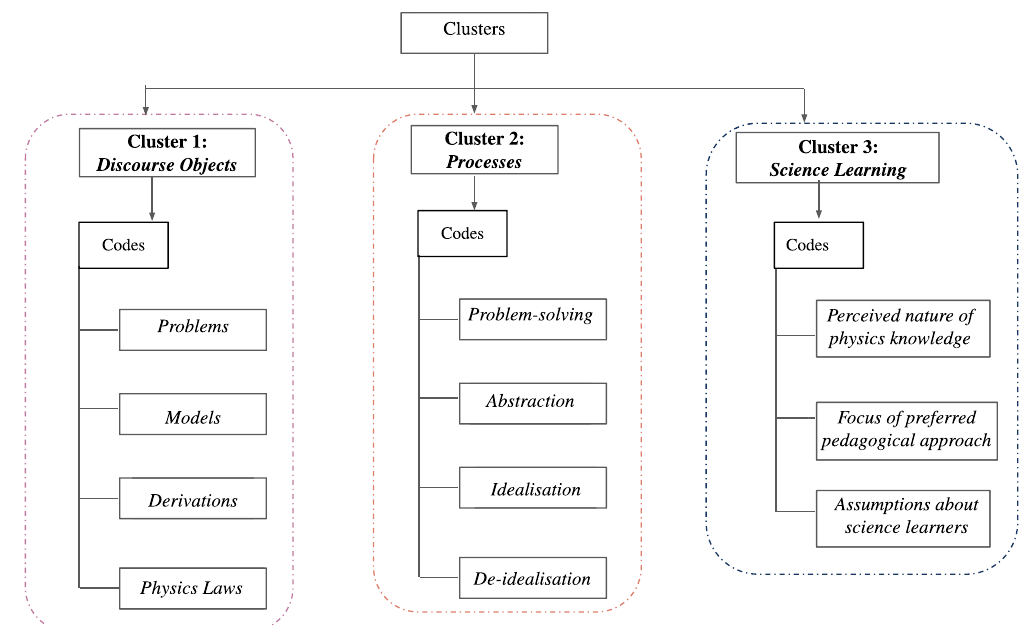
FIG. 9. A taxonomy of the codes developed using an inductive approach to data coding. As is evident from the diagram, we labeled our first cluster “ discourse objects. ” Here, we define discourse objects as operative procedures that embed within them psychological processes such as inference, deduction, categorization, generalization, learning, and decision-making. Next, we labeled our second cluster “ processes. ” By processes, we mean any mental or cognitive function that is involved in the acquisition, use, interpretation, manipulation, and transformation of knowledge. Finally, we labeled our third cluster “ science learning. ” The codes contained within this cluster conveyed beliefs and assumptions about science teaching and